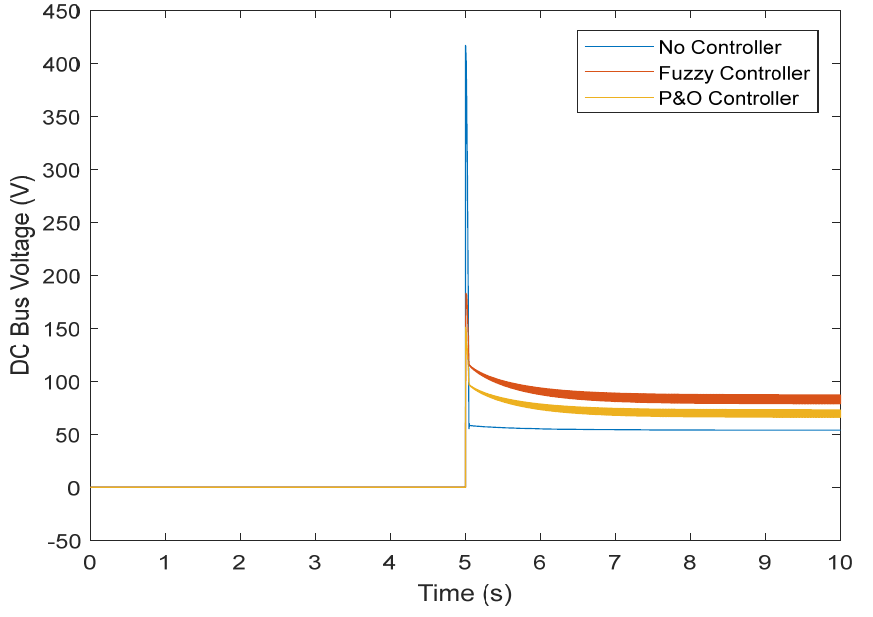
Figure 18. DC link voltage in the transient state.